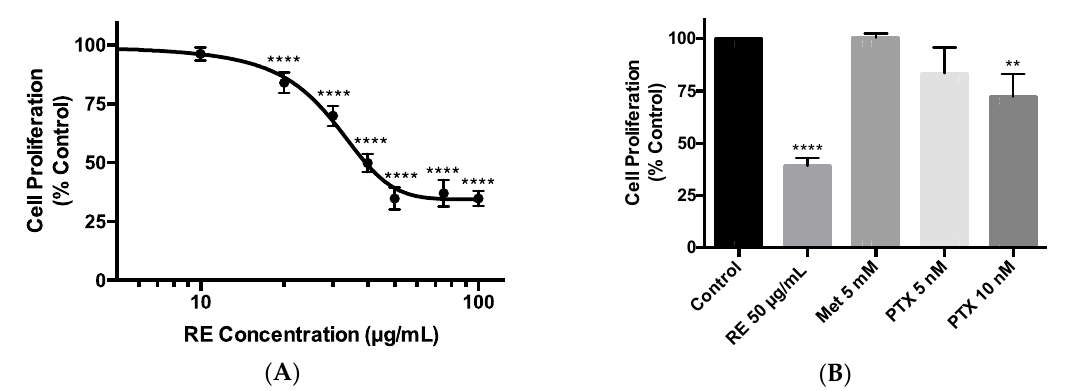
Figure 1. Effect of rosemary extract on MDA-MB-231 breast cancer cell proliferation. MDA-MB-231 cells were treated with 10, 20, 30, 40, 50, 75, or 100 µg/mL of rosemary extract (RE) ( A , B ), metformin (Met) ( B ), or paclitaxel (PTX) ( B ) for 72 h, followed by fixing and staining with 0.5% crystal violet. The stain was solubilized, and absorbance was read at 570 nm. Data are expressed as percent of control, untreated cells. Data are the mean ± SEM of six independent experiments. ** p < 0.01, **** p < 0.0001.